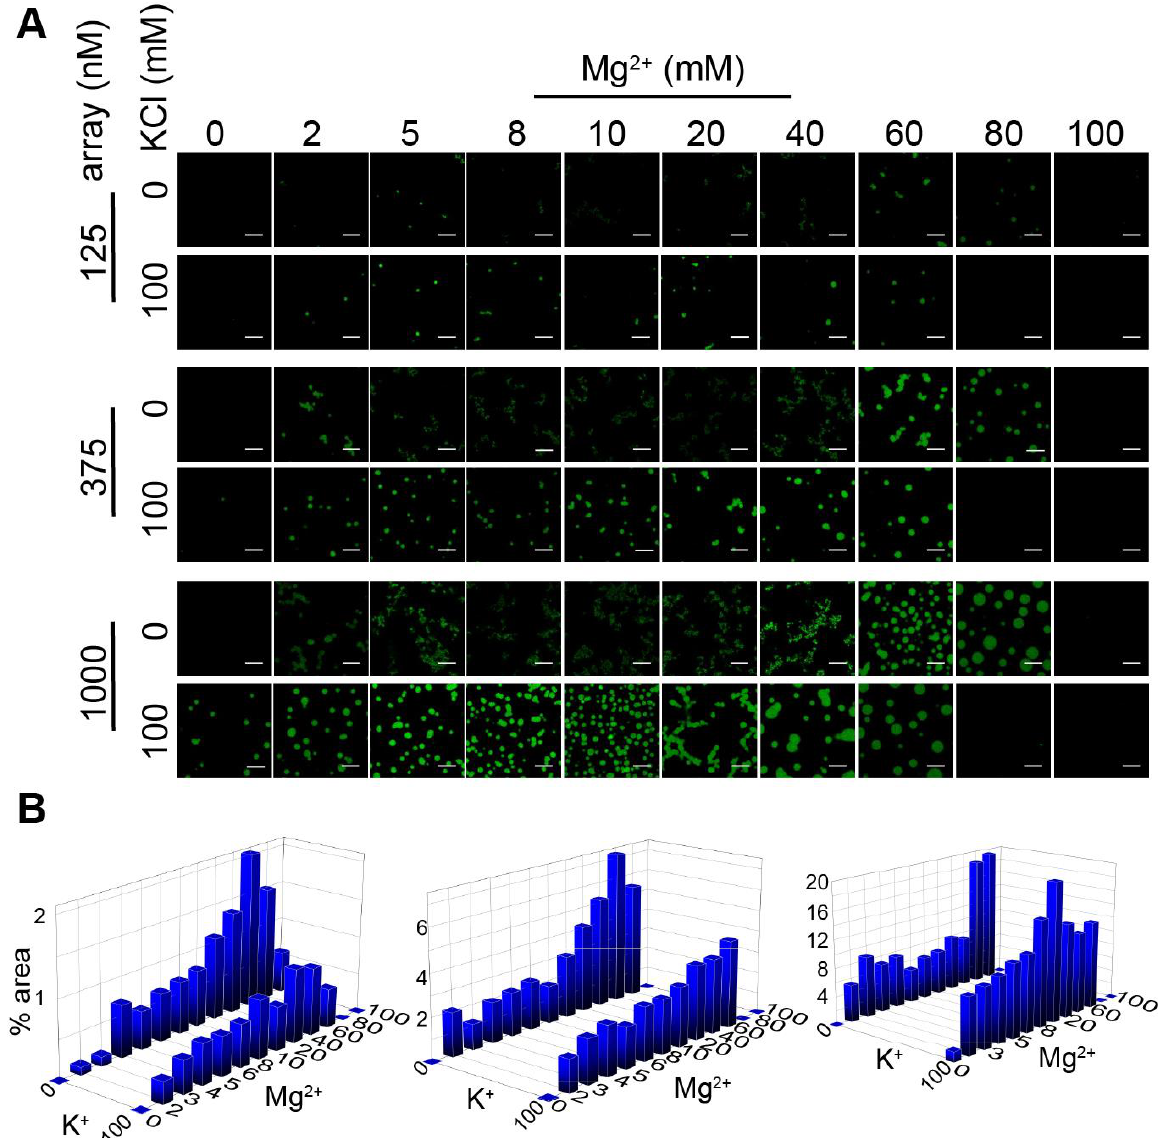
Figure 1. Reconstituted nucleosome arrays undergo LLPS in a salt-dependent manner. ( A ) Confocal fluorescence microscopy images of 15-197-601 nucleosome arrays with DNA stained by DyeCycle in the absence and presence of 100 mM KCl at various MgCl 2 and nucleosome array concentrations. Images for samples in conditions with wider range of MgCl 2 concentrations are shown in Figure S1. ( B ) Quantified percentages of fluorescent condensate areas in the images as a function of KCl and MgCl 2 concentrations for nucleosomes arrays with a concentration of 125 nM ( left ), 375 nM ( middle ) and 1000 nM ( right ). Scale bar represents 10 μ m.